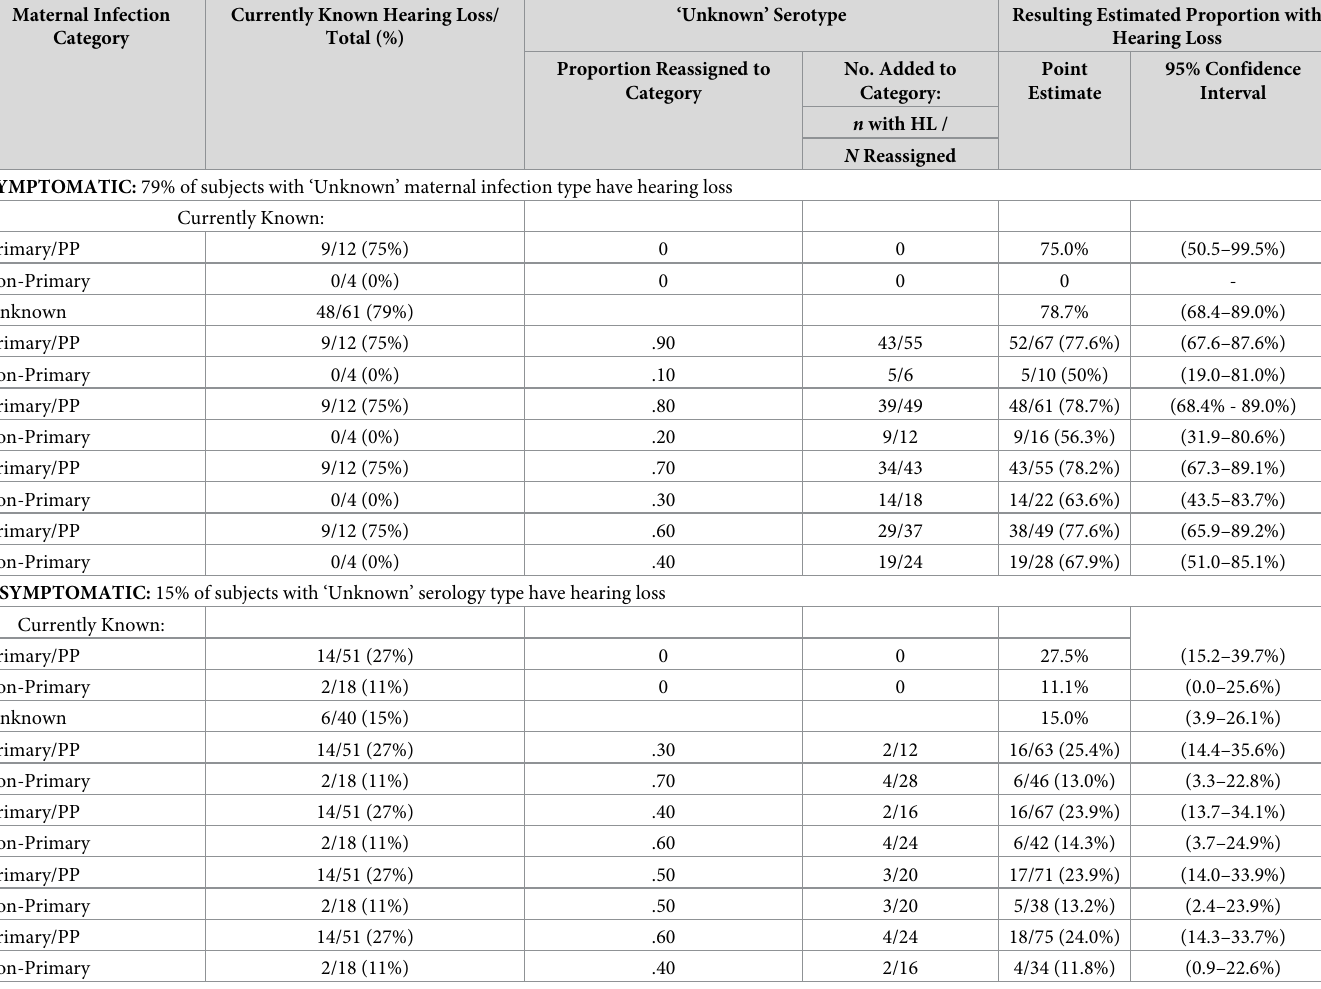
Table 6. Simulated reassignment of symptomatic and asymptomatic subjects with unknown type of maternal infection to primary or recurrent maternal infection categories, and the resulting percentages of sensorineural hearing